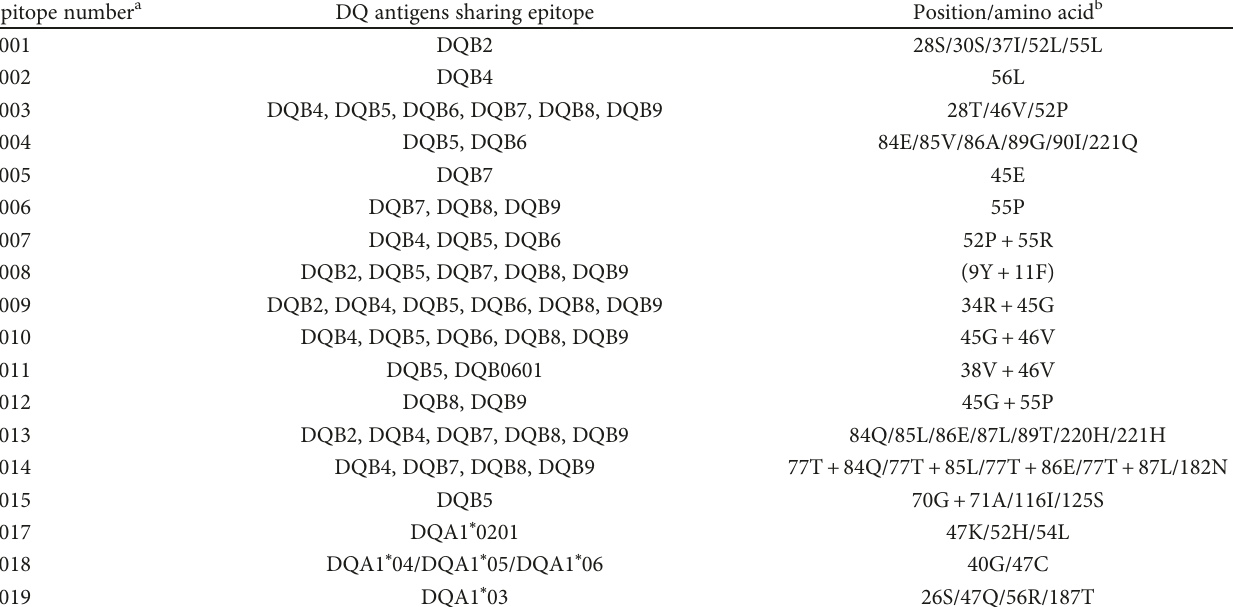
Table 7: Fifteen HLA class II DQ β epitopes and three DQ α epitopes de fi